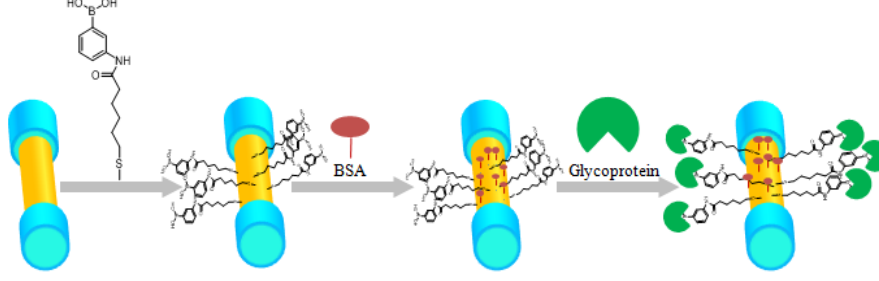
Figure 2. Decoration procedure on the SPR sensing region and application in glycoprotein detection, the sensor was dipped in boronic acid derivative for 24 h, which the TFBG-SPR would self-assemble with the molecules and then block the unreacted carboxyl by dipping the sensor to the BSA, different concentrations of glycoprotein, and different kinds were detected in the end.